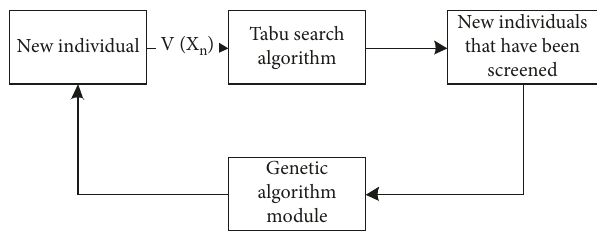
Figure 2: Hybrid genetic tabu search